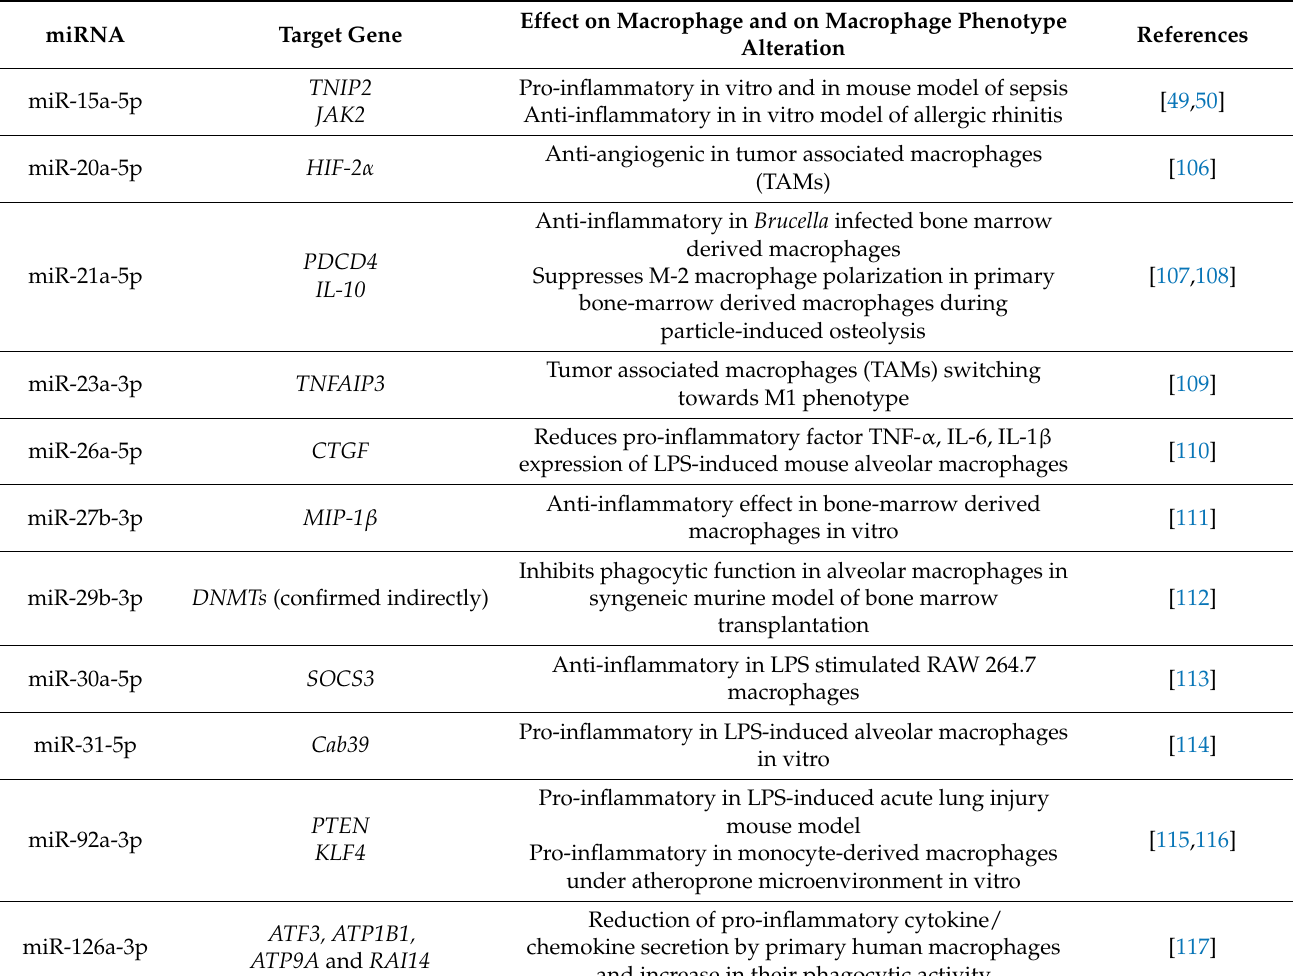
Table 2. Selected miRNAs that are potentially involved in MetS pathogenesis due to their involvement in macrophage phenotype regulation. Please note that contradictory results are due to different experimental approach and model